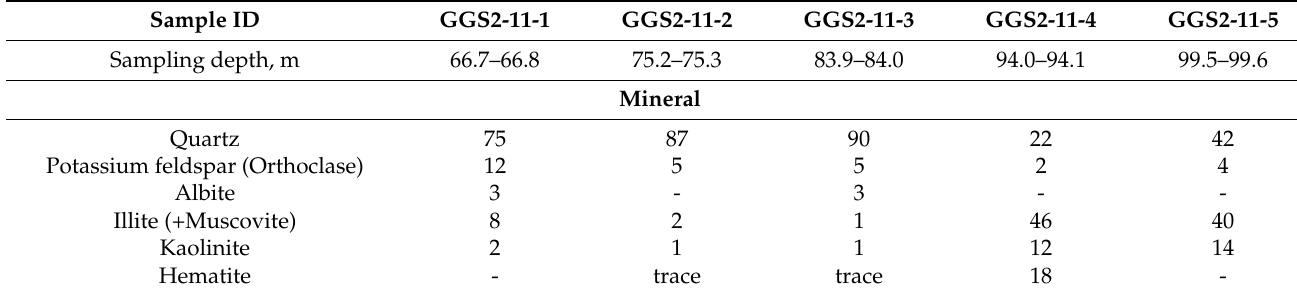
Table A1. Mineral composition of sedimentary rock samples (wt %).